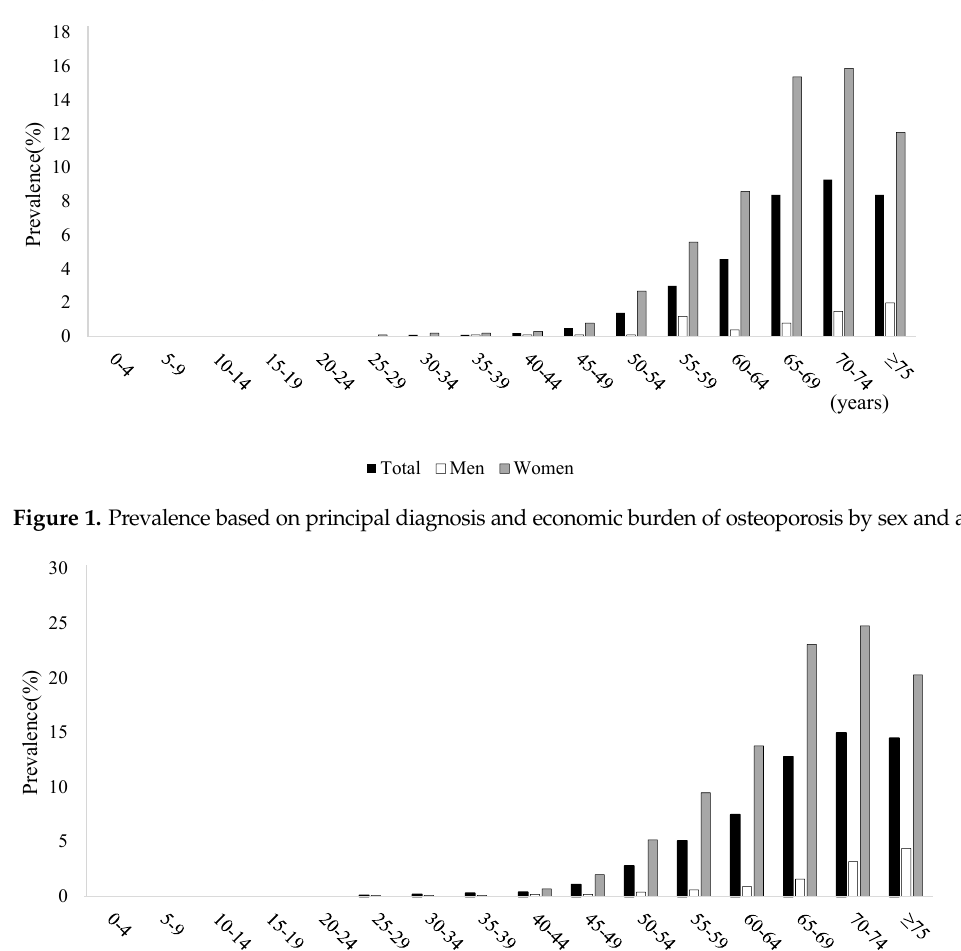
Figure 2. Prevalence based on principal or second diagnosis and economic burden of osteoporosis by sex and age.